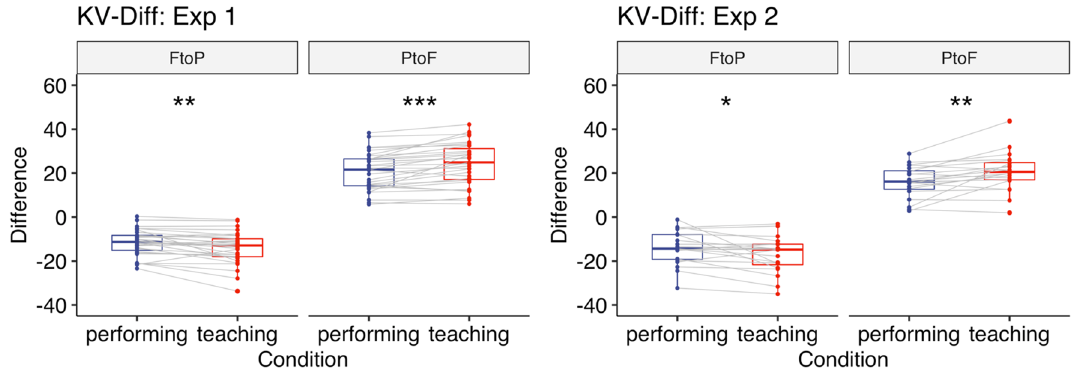
Figure 9. Experiment 1, 2: KV Difference at transition points when playing the piece with dynamics (left: Experiment 1, right: Experiment 2). Each box indicates the IQR with the median, and whiskers extend to a maximum of 1.5 × IQR beyond the box. Significance levels: * < 0.05, ** < 0.01, *** <